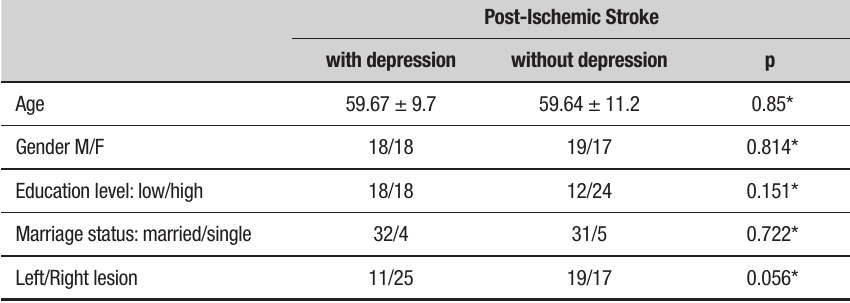
Table 1. Basic characteristics of the two groups.